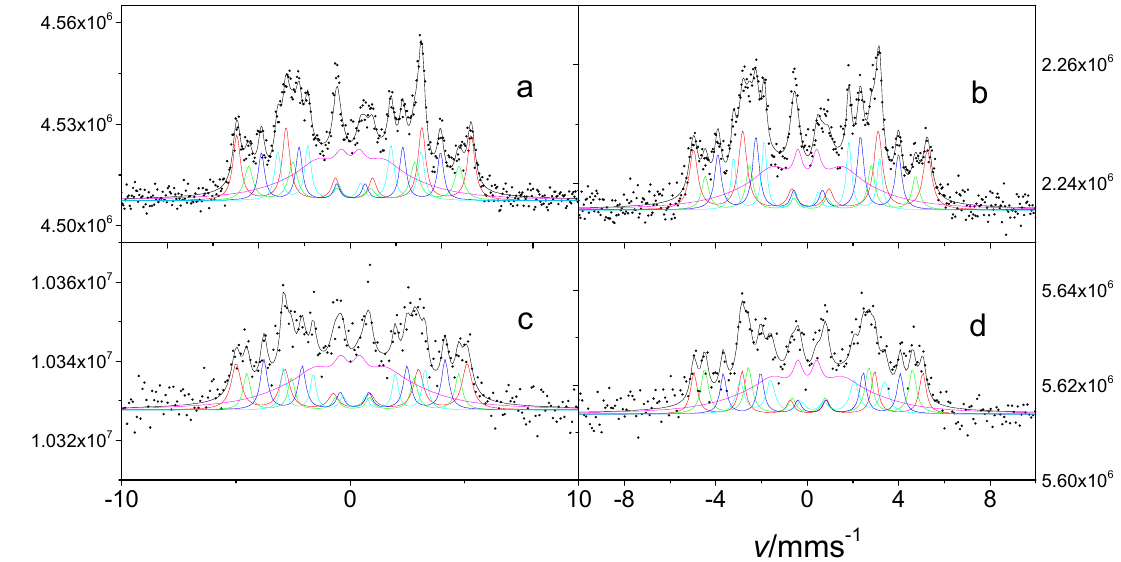
Figure 6 . Room temperature 57 Fe conversion electron Mössbauer spectra of FINEMET samples CK021 ( a , c ) and CK022 ( b , d ), non-irradiated ( a , b ) and irradiated with 160 MeV 132 Xe ions with a fluence of 10 13 ion cm − 2 ( c , d ). Table 3 . Effect of swift heavy ion irradiation on the orientation of magnetization at the surface of differently stress-annealed FINEMET ribbons.